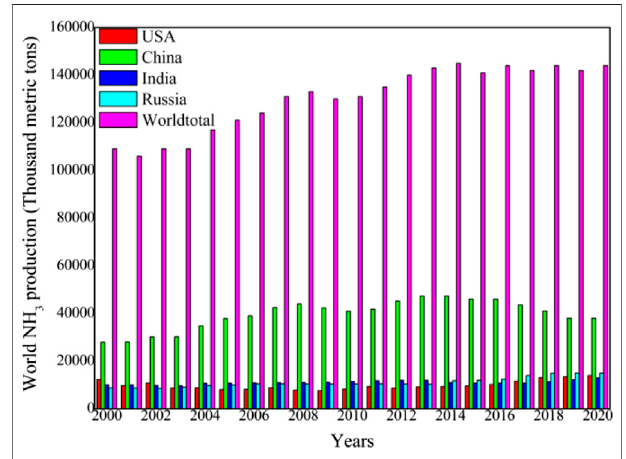
FIGURE 2 | World NH 3 production (Data from USGS, 2021).